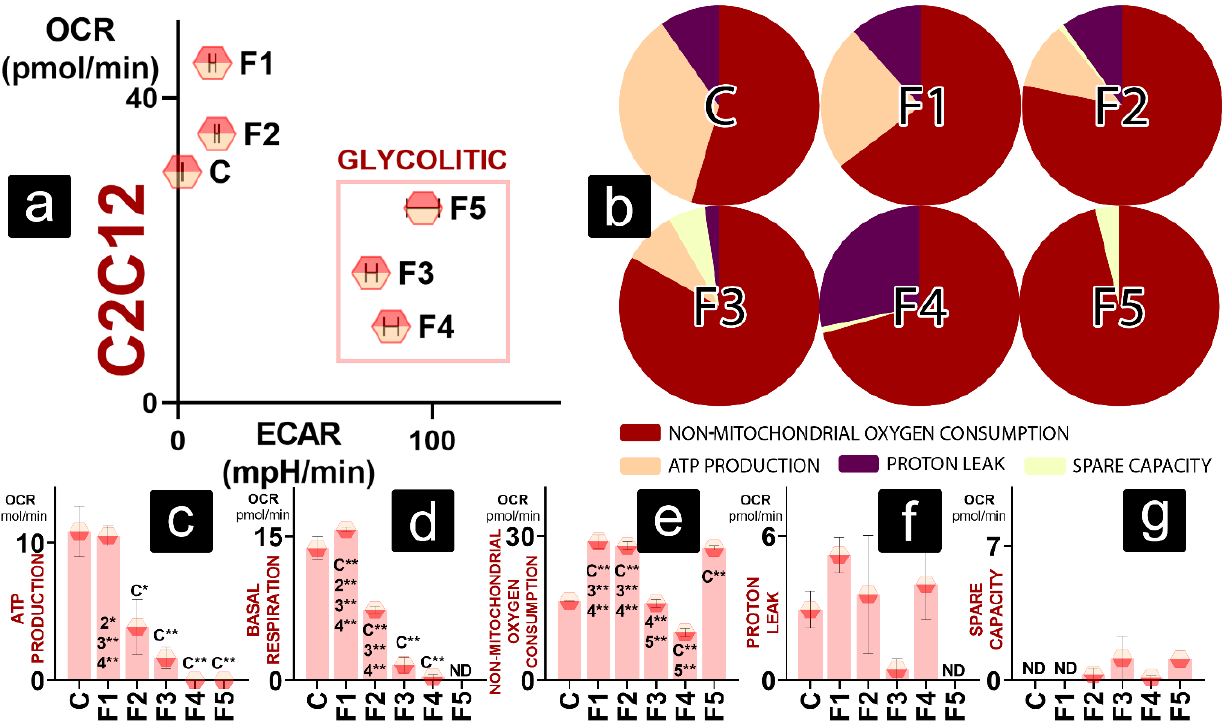
Figure 5. Bioenergetics of C2C12 cells showing ( a ) metabolic profile in normal conditions; ( b ) maximal OCR established as 100% and the oxygen consumption allotted between non-mitochondrial OCR, ATP-linked OCR, proton-leak-linked OCR, and spare-capacity-linked OCR; OCR values for ( c ) ATP production, ( d ) basal respiration, ( e ) non-mitochondrial oxygen consumption, ( f ) proton leak, and ( g ) spare capacity. p < 0.01 (*) or p < 0.05 (**).